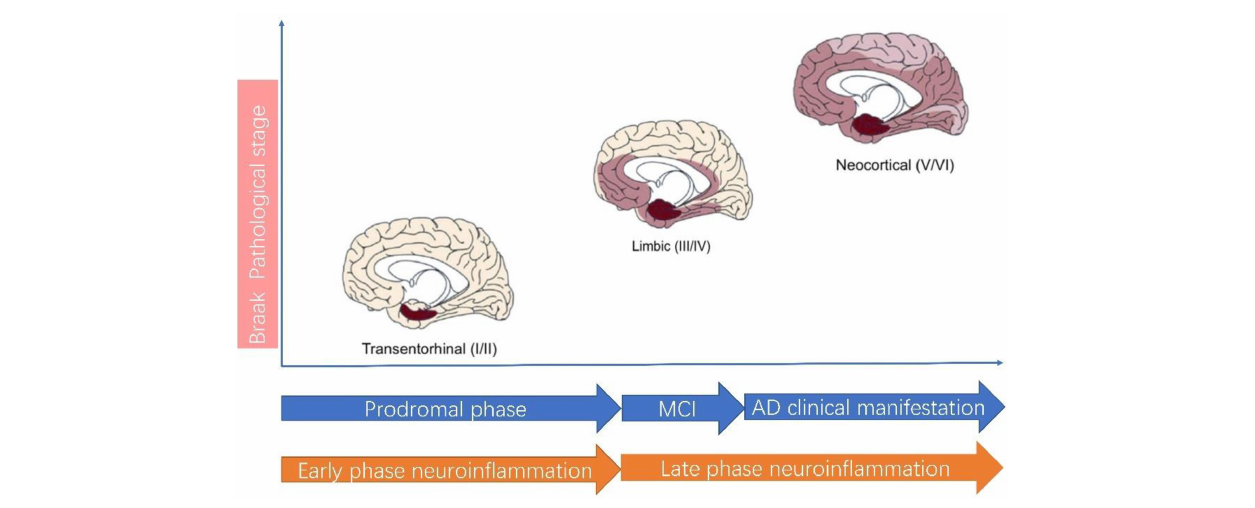
FIGURE 2 | Alzheimer’s disease pathological staging versus clinical staging and neuroinflammation staging. According to AD Braak pathological staging (Braak and Braak, 1991), AD can be staged as I–II: Transentorhinal stages, III–IV: limbic stage and V–VI: Neocortical stage. The Transentorhinal stage roughly corresponds to prodromal phase of clinical AD and Early phase neuroinflammation. In Early phase neuroinflammation, microglia assume a detrimental role. The MCI (mild cognitive impairment) stage of clinical AD roughly corresponds to the beginning of Late phase neuroinflammation, during which the neuroinflammation wanes down.